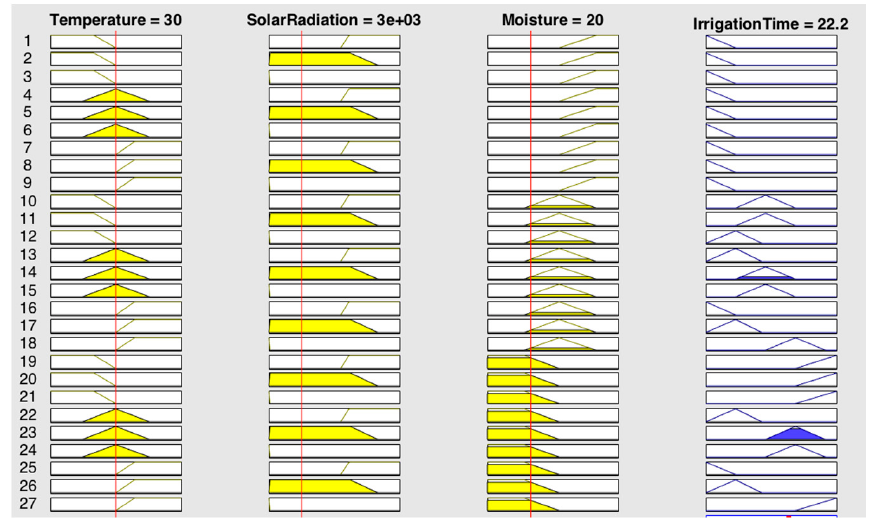
Figure 13. Output simulation.